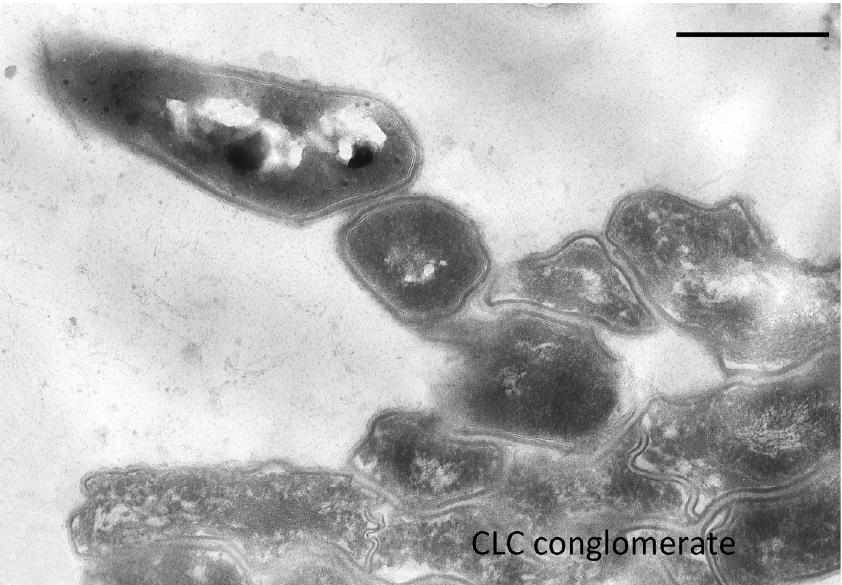
Figure 7. Ultrathin section of CLC conglomerate of G. polyisoprenivorans 135 (2 years storage). Bar— 1 μ m.